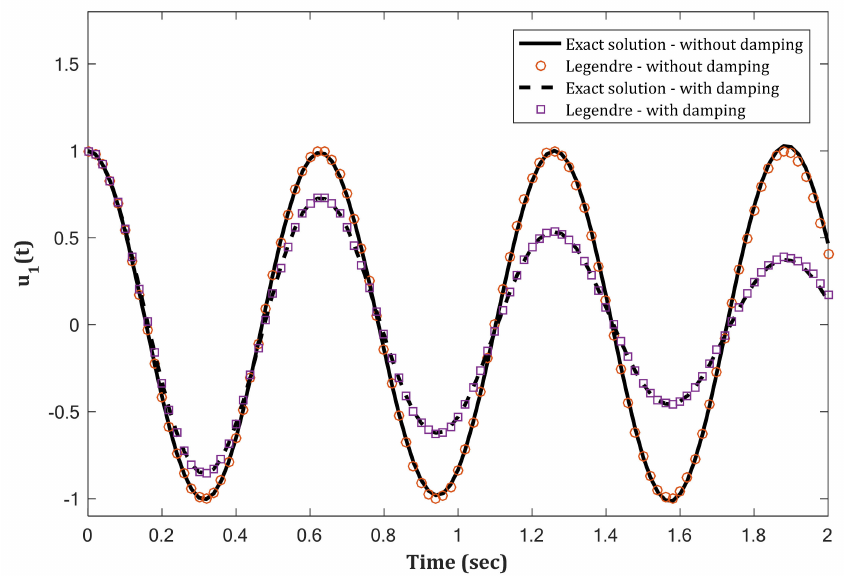
Figure 3. Free vibration analysis for a 2DOF system. Comparison of u 1 ( t ) as a function of time, as obtained from the LGM method or the exact solution.